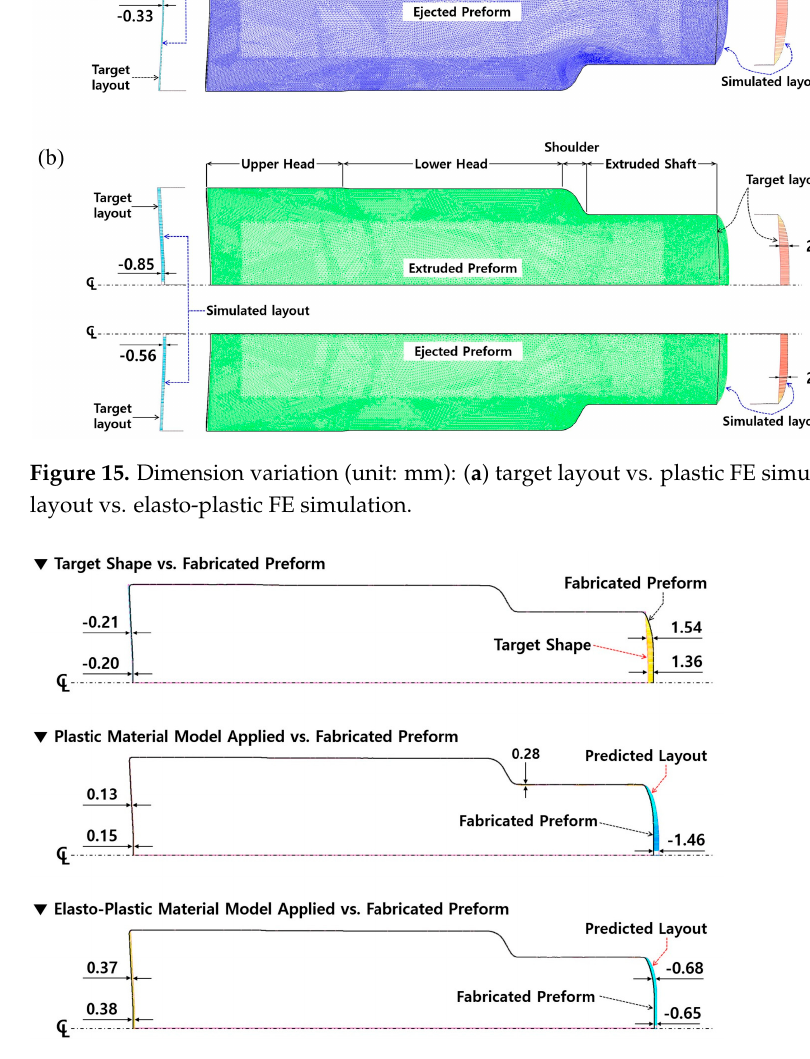
Figure 16. Comparison of dimensional suitability between fabricated and numerically simulated preforms (unit: mm).